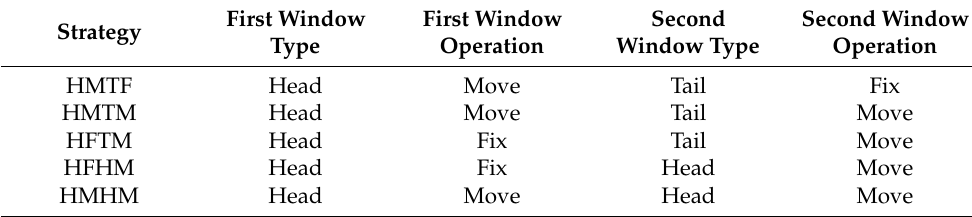
Table 1. Window moving